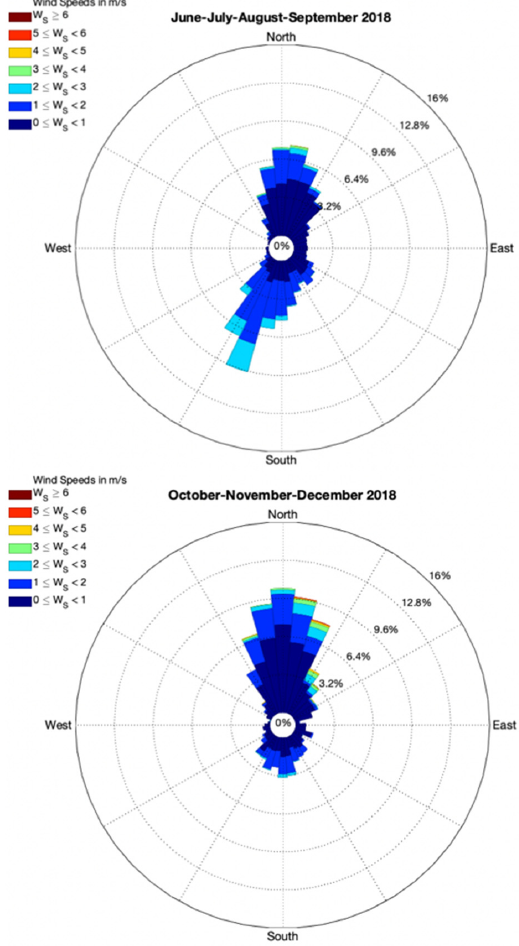
Figure 3. Yearly and seasonal wind roses from hourly values of wind direction and wind speed observed in 2018 at the Domodossola meteorological station operated by ARPA Piemonte (http://www.arpa.piemonte.it/; accessed on 26 April 2021).